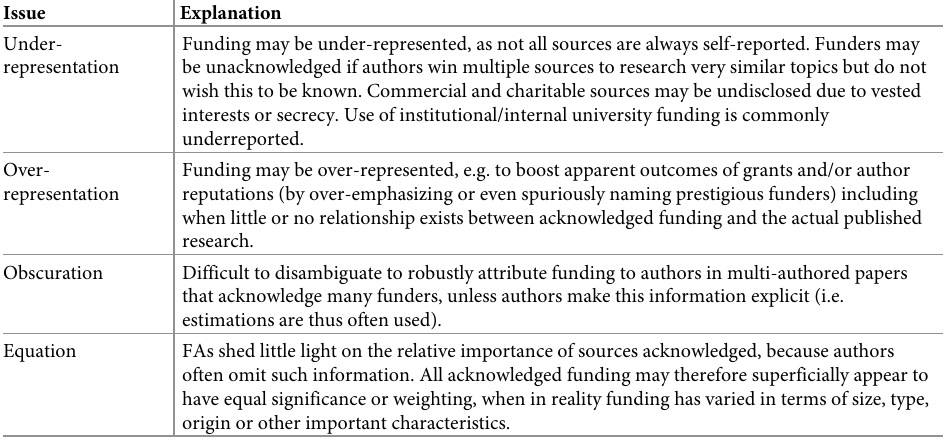
Table 3. Limitations of FAs as a data source due to author acknowledging behaviours. [See 35, 36, 39, 40, 43, 44, 47–49,